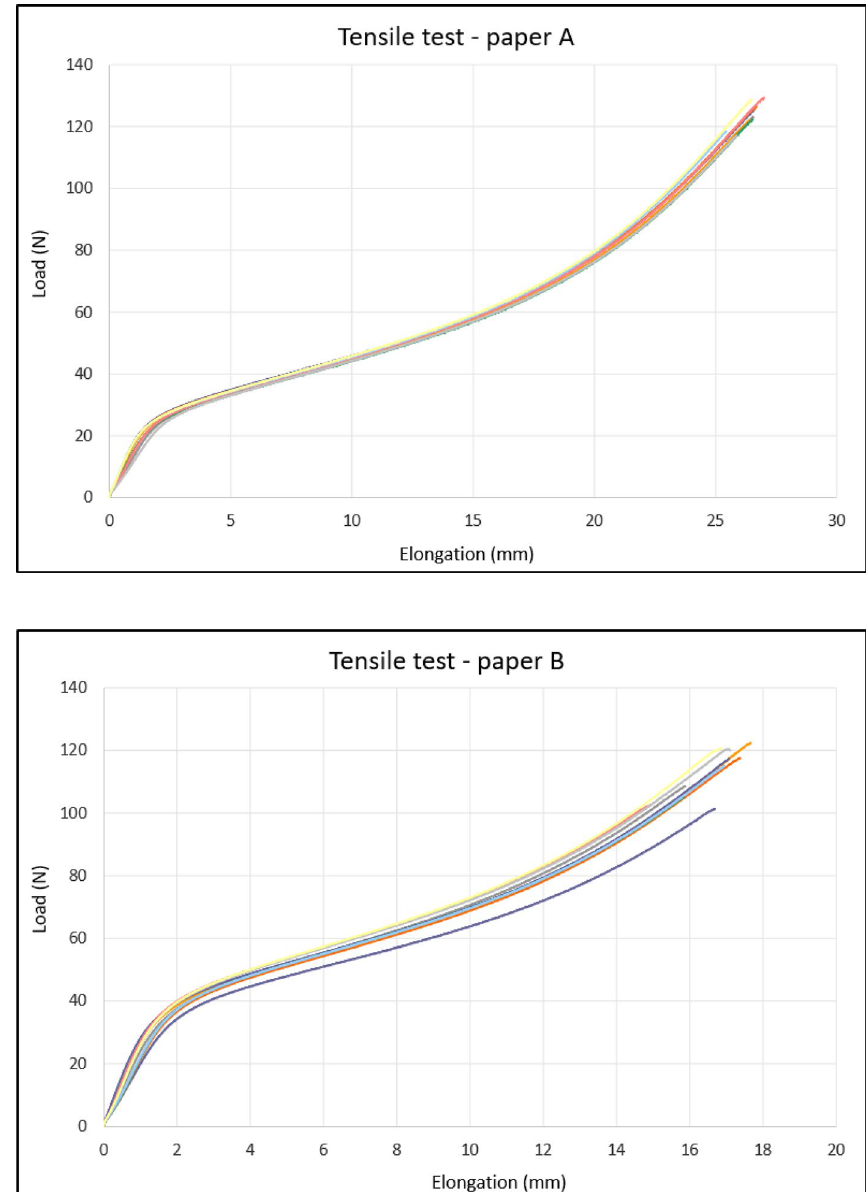
Fig. 24 Force elongation curves of individual specimen of paper A